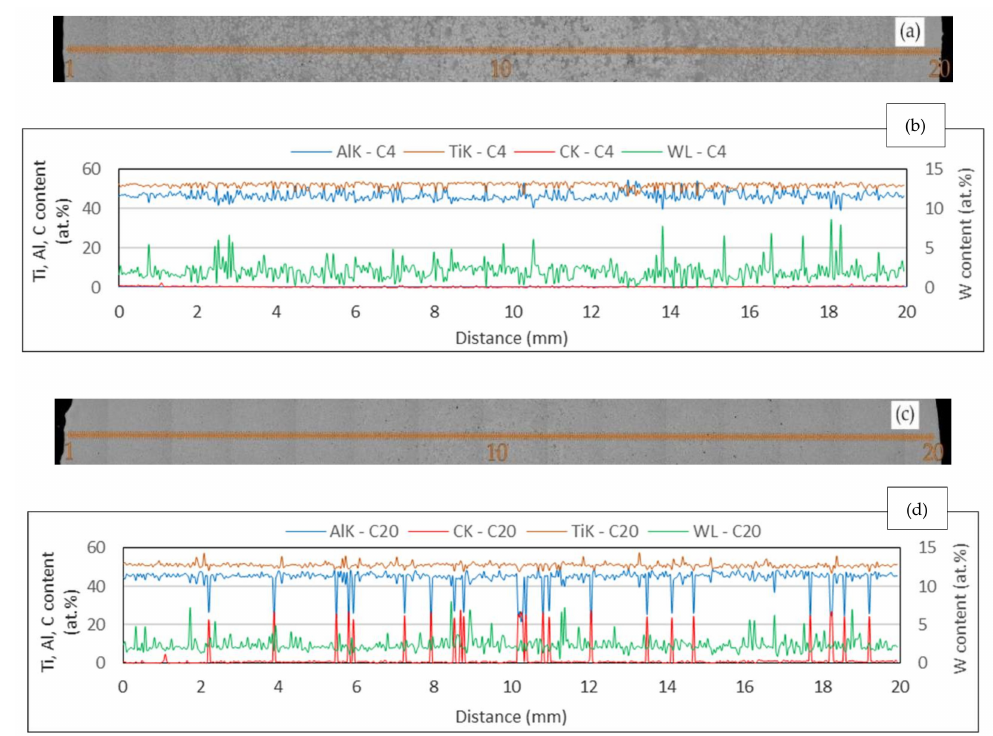
Figure 8. EDS concentration profiles of the alloying elements: ( a ) position of measurement points during the line analysis at a transversal section of the C4 ingot; ( b ) concentration profile of elements in the C4 ingot; ( c ) position of measurement points during the line analysis at a transversal section of the C20 ingot; ( d ) concentration profile of elements in the C20